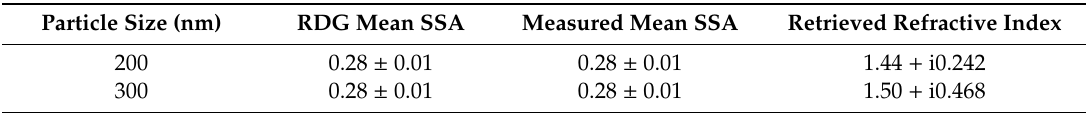
Table 3. Mean SSA values from experimental and RDG calculations and retrieved average refractive index for olive fuel.